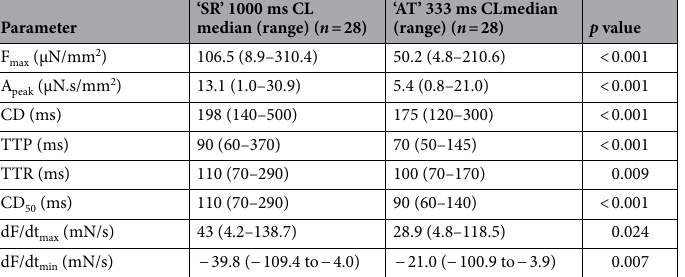
Table 2. Comparison of contractility parameters between sinus rhythm (SR) with 1000 ms CL and atrial tachyarrhythmia (AT) with 333 ms CL stimulation, presented as median (range). F max and A peak were corrected with LMS area. A peak peak area, CL cycle length, CD contraction duration, CD 50 width at 50% of peak height, dF/dt